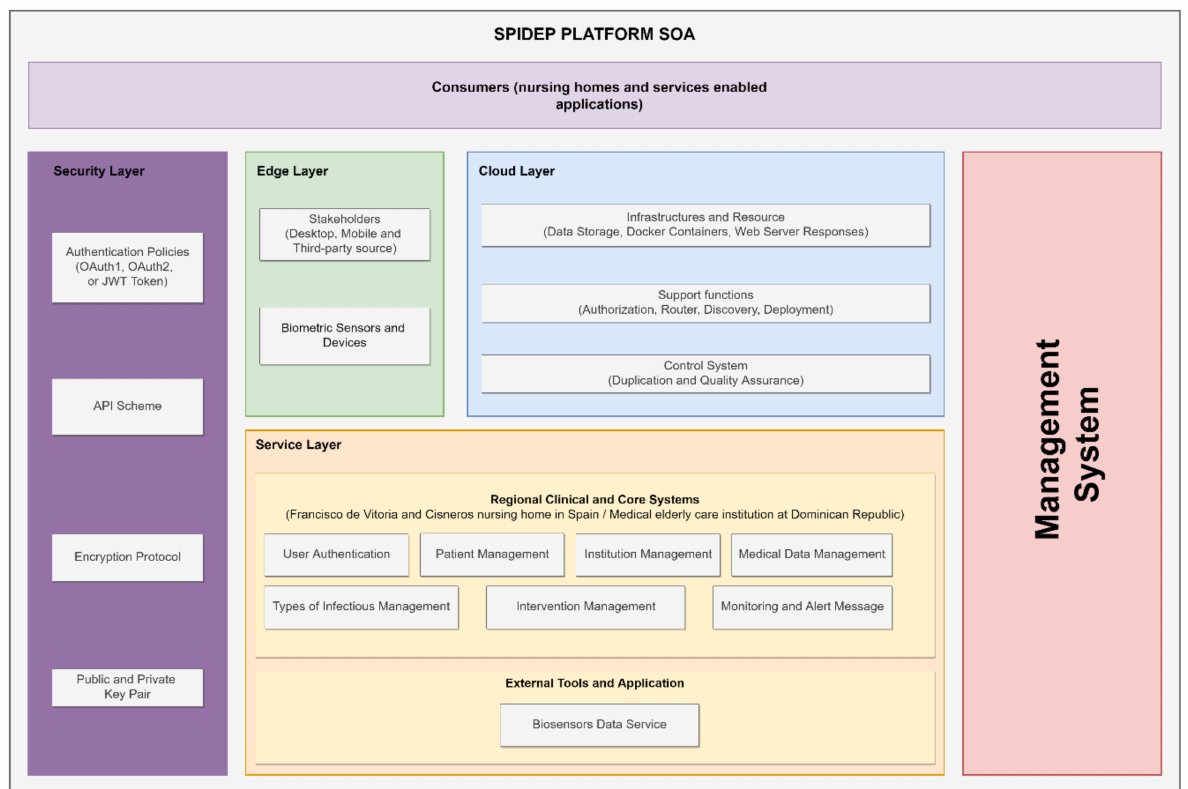
Figure 1. General scheme of the services applied in the SPIDEP platform under the SOA variant